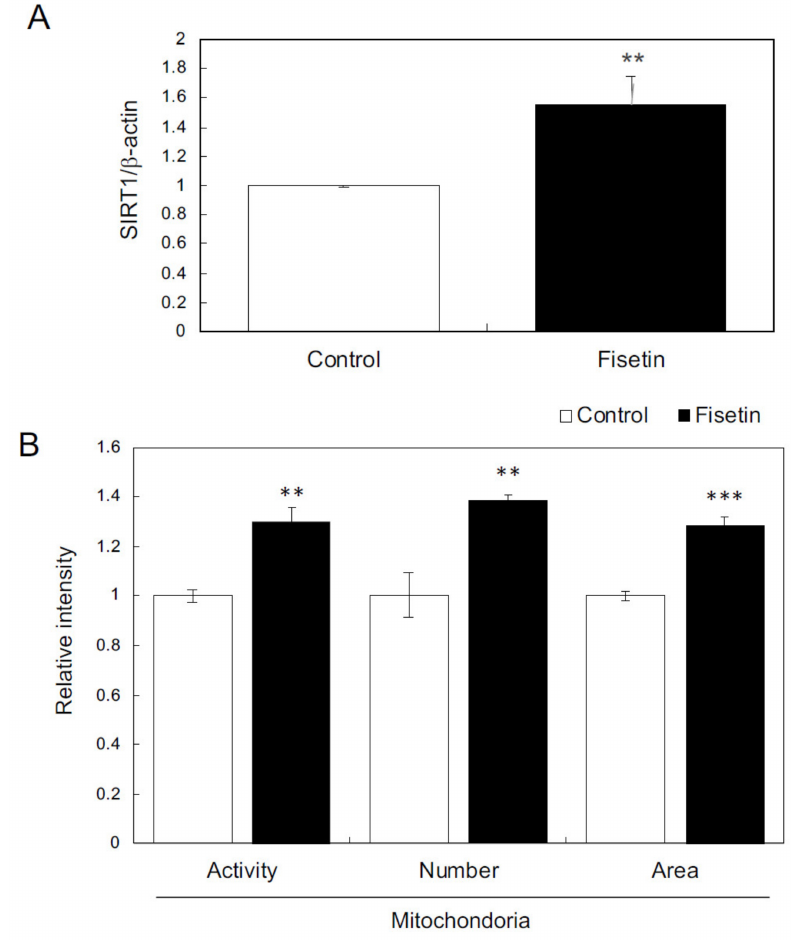
Figure 3. Effects of fisetin on keratinocytes. ( A ) The expression of SIRT1 in HaCaT cells was evaluated using qRT-PCR. ( B ) Effects of fisetin on mitochondria evaluated using mitochondrion-specific probes (MitoTracker Red CMXRos and MitoTracker Green FM) and IN Cell Analyzer 2200. Statistical significance was determined using a two-sided Student’s t-test. Statistical significance was defined as p < 0.05 (** p < 0.01; *** p < 0.001). Table 1. Functional annotation.